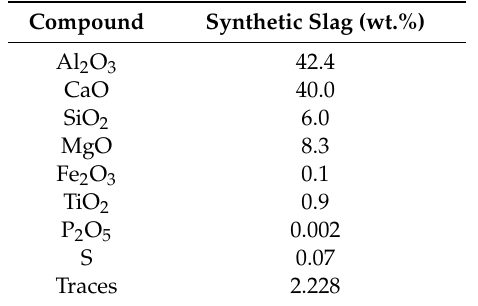
Table 3. Chemical composition of the synthesized ladle slag.